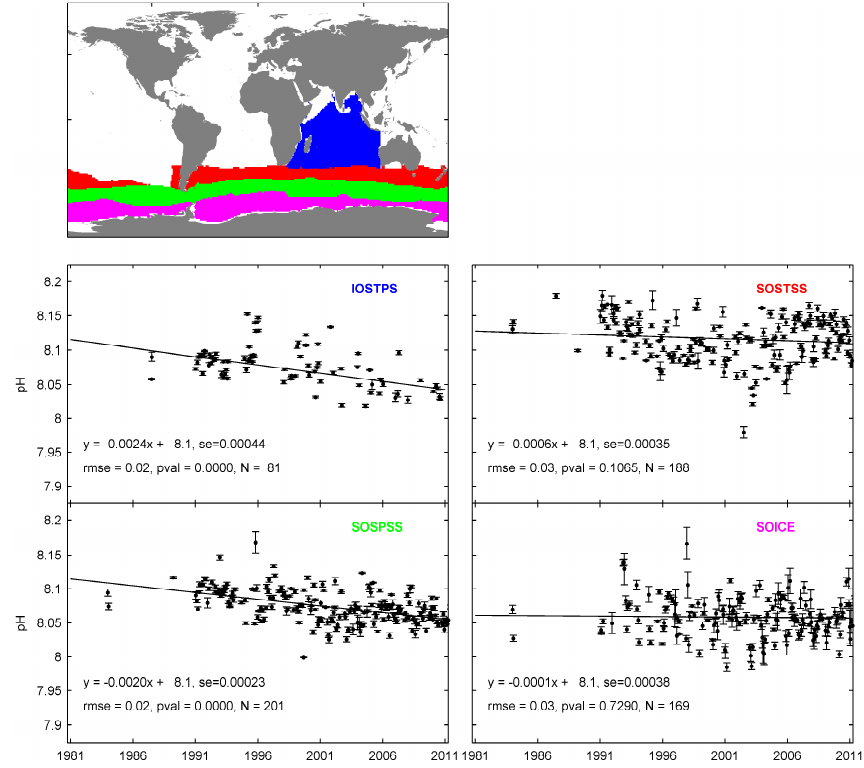
Figure 4. Long-term pH trend (1981–2011) in the Indian Ocean biome and the three Southern Ocean biomes.